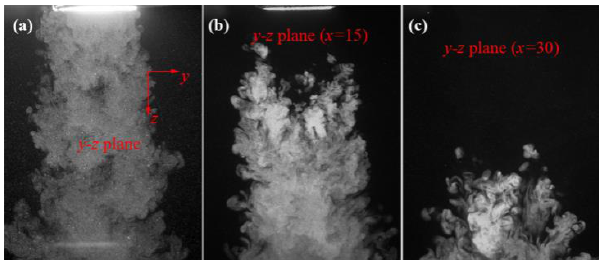
Figure 6. The visualized airflows in the “ x-z plane ( y = 30)” at different time instants of ( a ) t = 0 s, ( b ) t = 0.1 s, and ( c ) t = 0.2 s. The real size for each sub-image is 141.8 mm × 72.6 mm. Figure 7. The visualized airflows in ( a ) the y-z plane, ( b ) the “ y-z plane ( x = 15)”, and ( c ) the “ y-z plane ( x = 30)”. The real size for each sub-image is 141.8 mm × 109 mm.